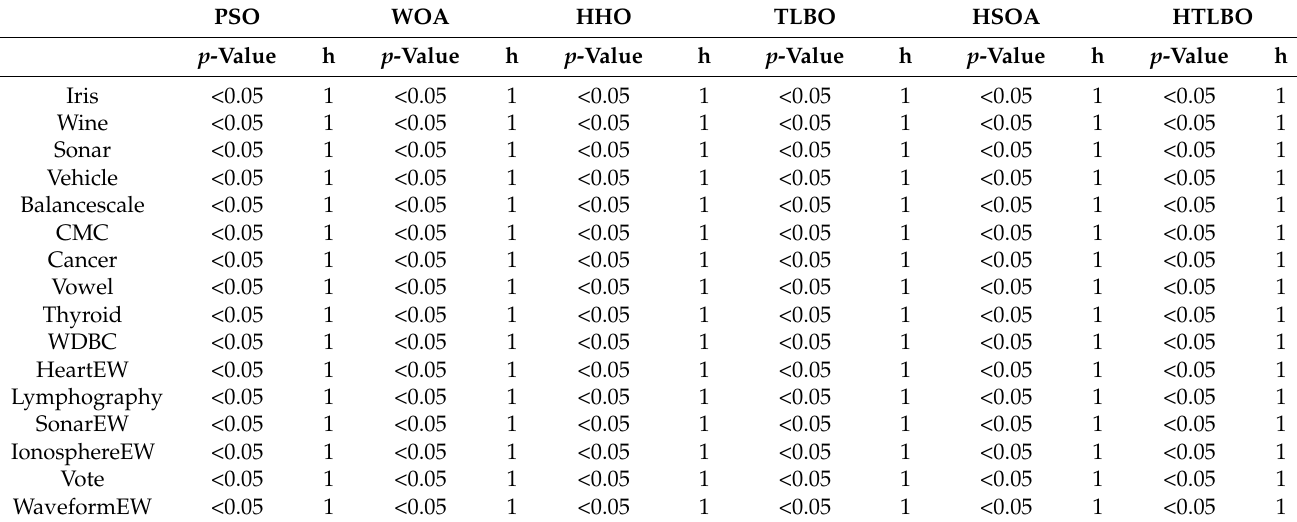
Table 9. Wilcoxon’s rank-sum test of classification